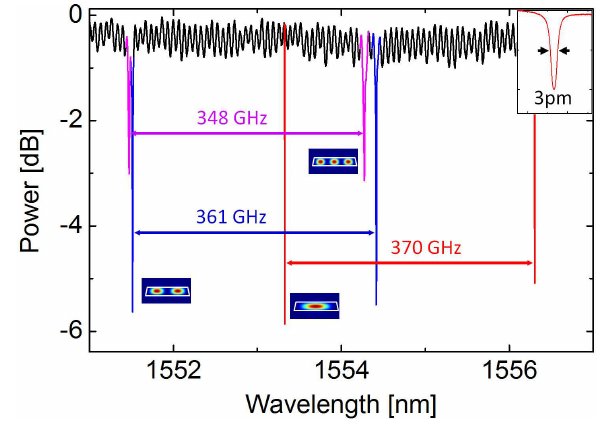
Figure 4: Transmission spectrum of AlN micro-ring with 650 nm by 3.5 µ m waveguide structure. With a 500 nm coupling gap, three TE modes are observed. The fundamental mode (red) resonances are used for comb generation. The inset shows the zoom-in of